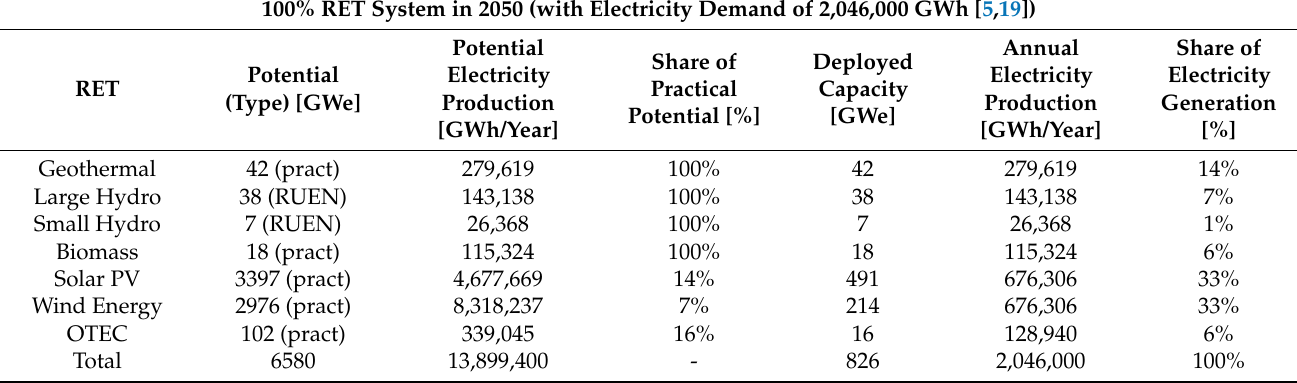
Table 7. 100% RET scenario until 2050 based on the reviewed